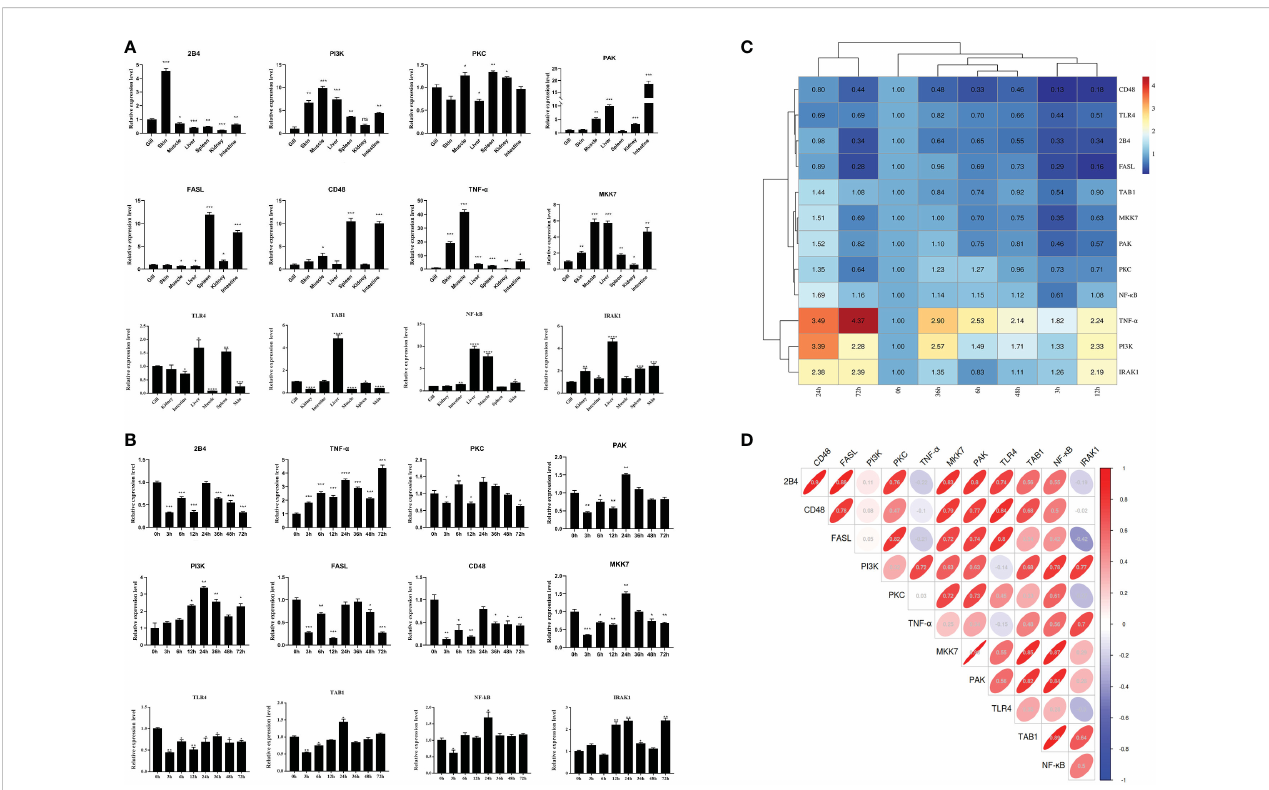
FIGURE 9 Expression changes of the immune-related target genes within the Toll-like receptor (TLR), mitogen-activated protein kinase (MAPK), and nuclear factor kappa B (NF- k B) in fl ammatory pathways of Carassius auratus . (A) Tissue distribution of the 12 microRNA (miRNA)-mediated potential target genes. (B) Temporal expression changes of the target genes in the gills. (C) Heat map analysis of the relative expression. (D) Correlation analysis of the selected target genes. Toll-like receptor 4 ( TLR4 ), interleukin-1 receptor-associated kinase 1 ( IRAK1 ), TGF-beta-activated kinase 1 and MAP3K7-binding protein 1 ( TAB1 ), protein kinase C lambda ( PKC ), Fas ligand ( FASL ), nuclear factor kappa-B kinase subunit alpha-like ( NF- k B ), P21-activated kinase ( PAK ), phosphatidylinositol 3-kinase ( PI3K ), MAP kinase kinase 7 ( MKK7 ), CD48 molecule ( CD48 ), CD244 molecule ( 2B4 ), and tumor necrosis factor- a ( TNF- a ), which were determined by quantitative real-time PCR (qRT-PCR) assay. All data were from three independent triplicate experiments (* p < 0.05, ** p < 0.01, *** p < 0.001, **** p <